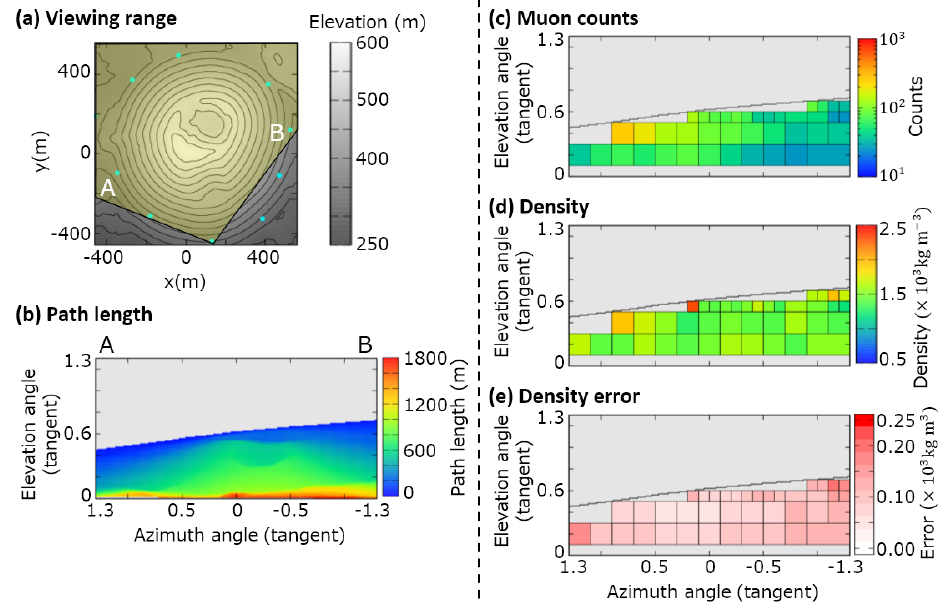
Figure B5. Observation site S. (a) Map, topography, and viewing range; (b) path length of the volcanic cone; (c) muon counts N obs (d) density ρ i . The maximum value of the color bar indicates a density of > 2 . 5 × 10 3 kgm − 3 and the minimum value is < 0 . 5 × 10 3 kgm − 3 . (cid:16) (cid:17) − ρ low ρ up / 2. The maximum value of the color bar indicates a density error of > 0 . 25 × 10 3 kgm − 3 . (e) Density error (cid:49)ρ = i i